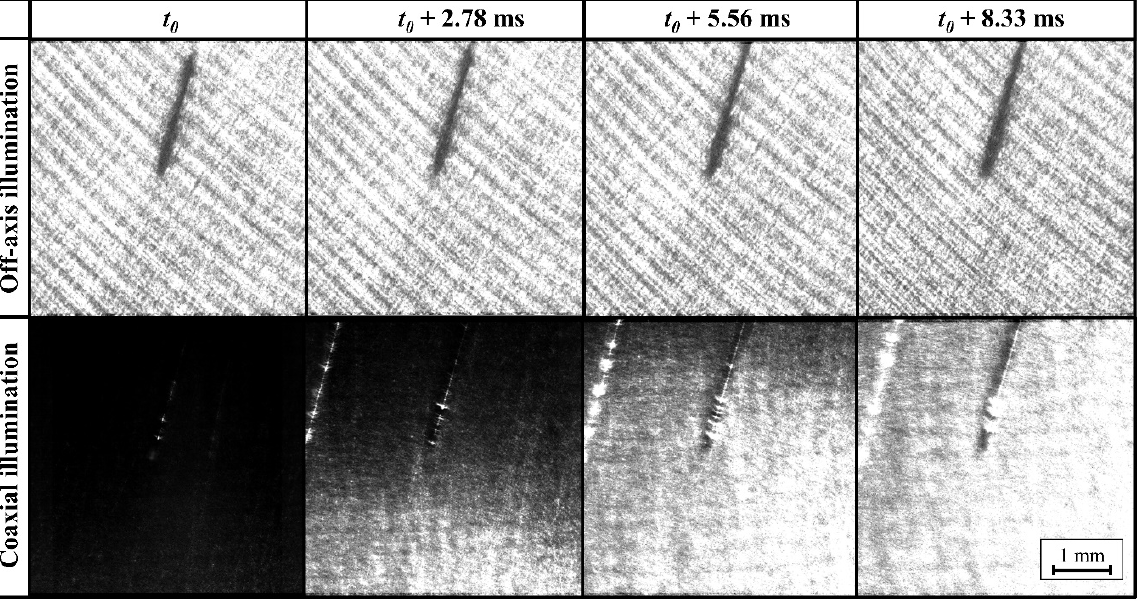
Figure 6. Series of frames of the molten pool at different time instants obtained when employing the illumination light in off-axis configuration. illumination light in off-axis